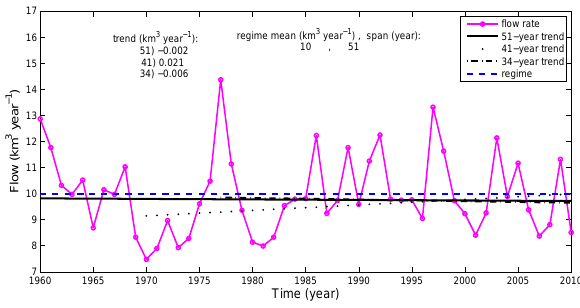
Fig. 6. Detected trends for three different analysis periods in Fond Fig.6. DetectedtrendsforthreedifferentanalysisperiodsinFondduLacRiver.Thesetrendsarenotsignificant( p -value ≥ 0.10). du Lac River. These trends are not significant ( p value ≥ 0.10).